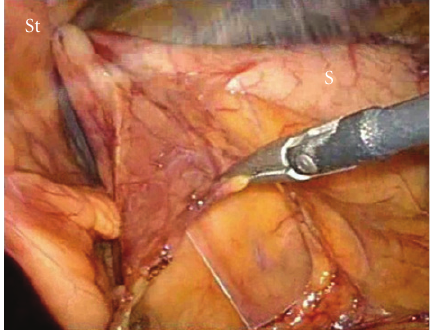
Figure 2: Opening of bursa omentalis. The stomach was retracted upwards with the help of stay sutures using prolene straight needle to the anterior abdominal wall. (St = Stay Sutures, S = Stomach.)